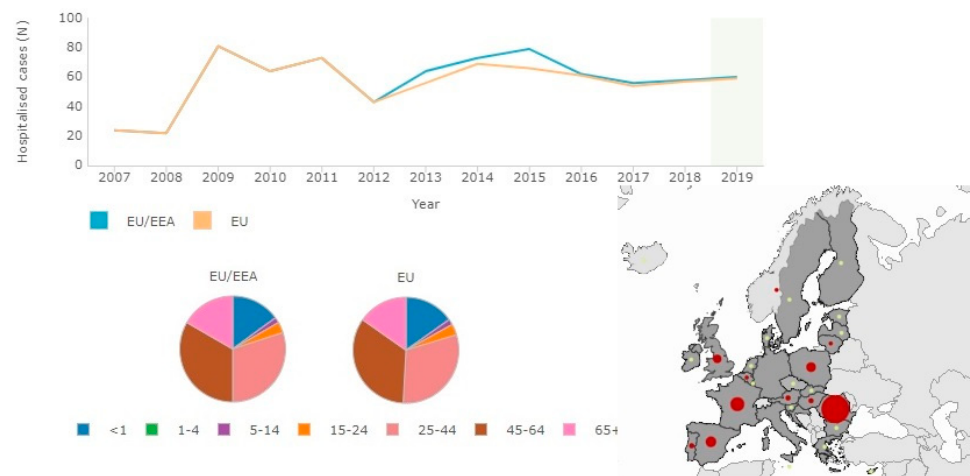
Figure 3. Sixty confirmed hospitalized cases for botulism in the EU/EEA in comparison with age (highest incidence aged 45–64) for 2019 (source: http://atlas.ecdc.europa.eu/public/index.aspx?Dataset=27&FixDataset=1, accessed date 5 July 2021).